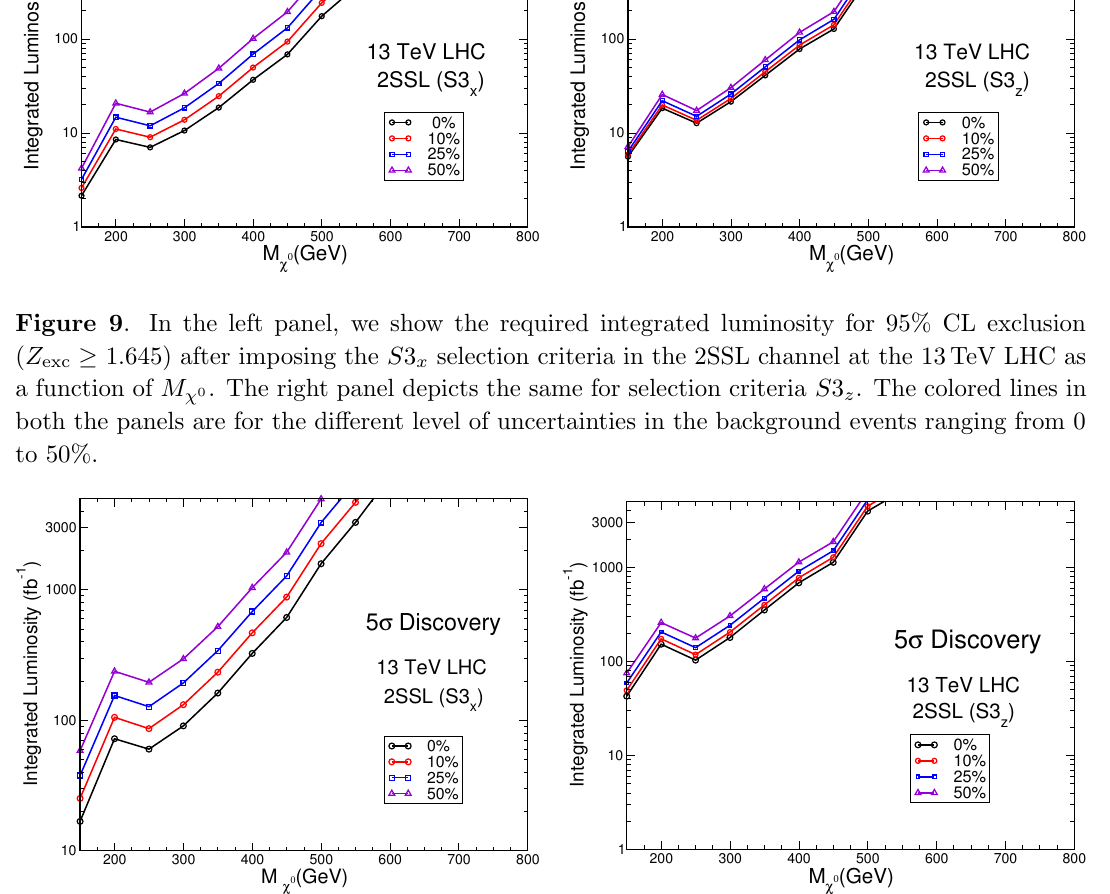
(cid:21) ) if (cid:31) 0 , even with x